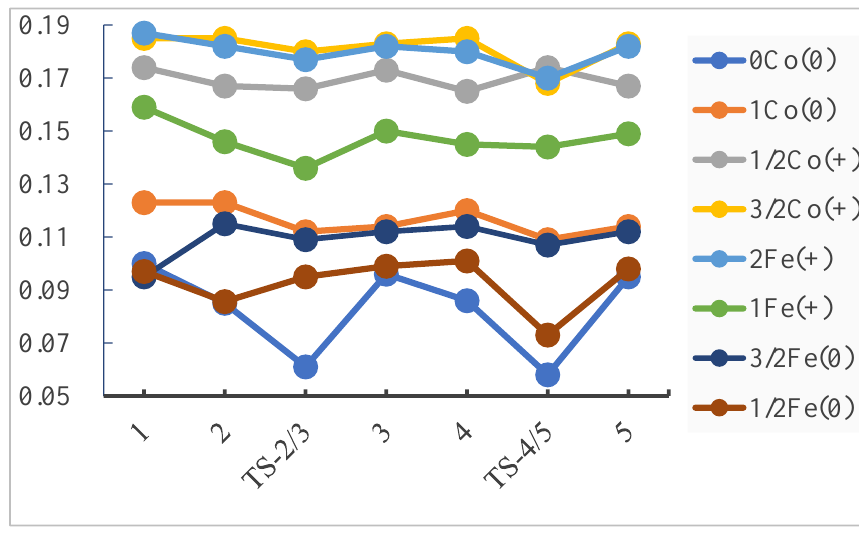
Figure 7. The structure parameter Δ calculated for both iron and cobalt species.